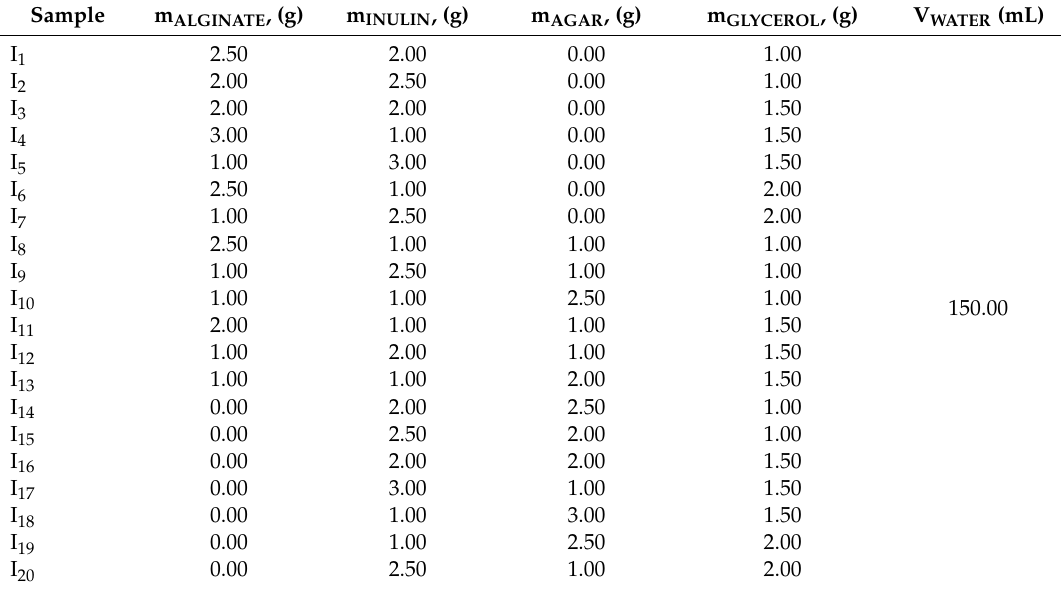
Table 3. The composition of edible